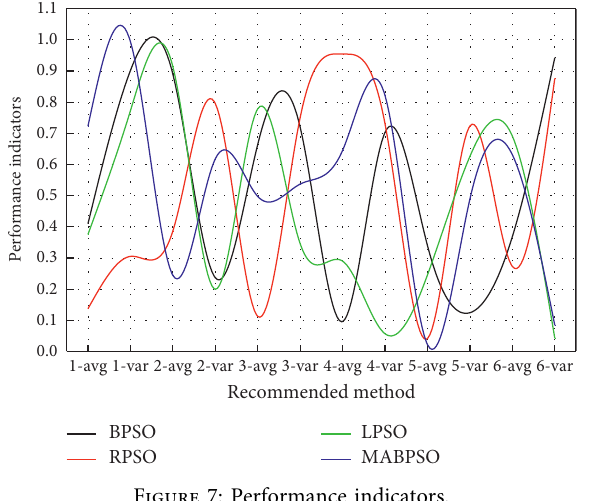
Figure 7: Performance